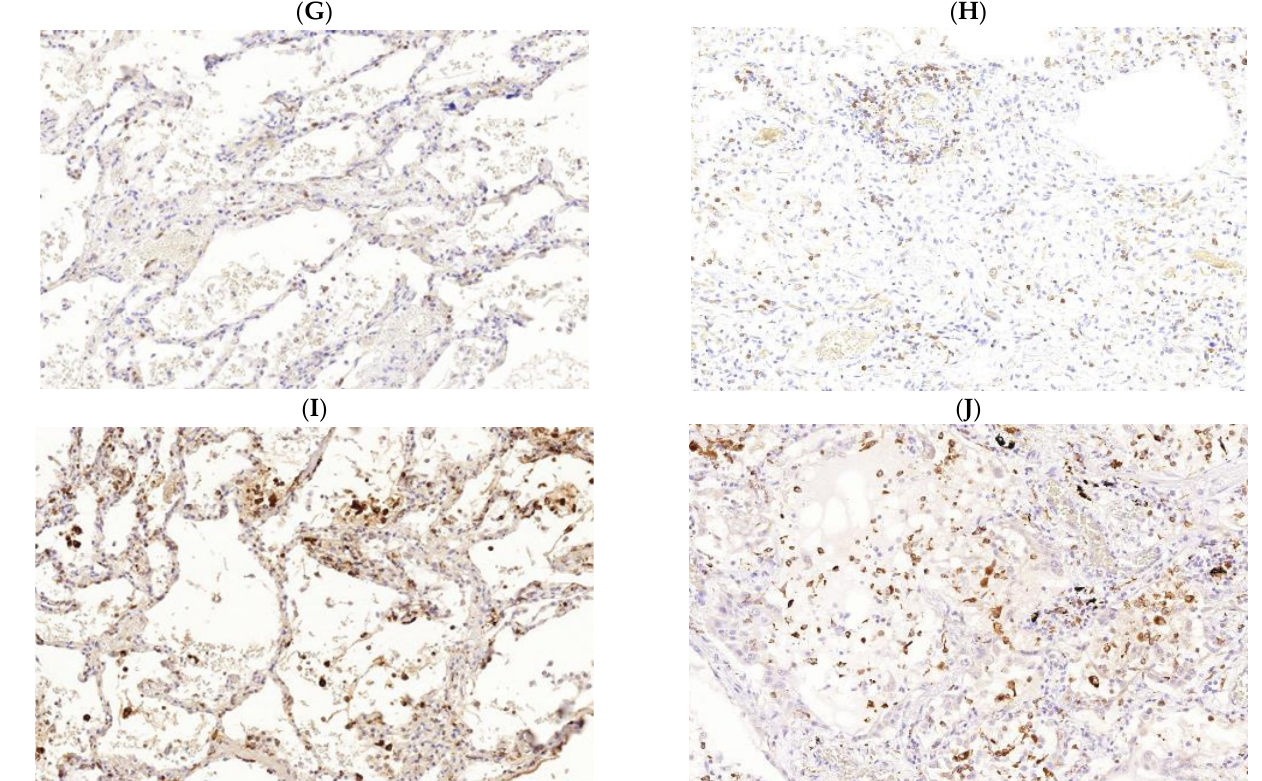
Figure 2. Immunomorphological characteristics of pathological cellular infiltration of the stroma of the lung’s respiratory parts among patients with new coronavirus infection caused by SARSCov2 (COVID-19). Acute (exudative) phase of diffuse alveolar damage (left). ( A ) staining with hematoxylin and eosin, ×400; ( C ) expression of CD3 (clone SP7, Diagnostic BioSystems, Pleasanton, CA, USA), ×400; ( E ) expression of CD4 (clone SP35, Cell Marque, Rocklin, CA, USA), ×400; ( G ) expression of CD8 (clone 144B, Diagnostic BioSystems, USA), ×400; ( I ) expression of CD68 (clone Kp-1, Cell Marque, USA. Late (proliferative) phase of diffuse alveolar damage (right). ( B ) staining with hematoxylin and eosin, ×400; ( D ) expression of CD3 (clone SP7, Diagnostic BioSystems, USA), ×400; ( F ) CD4 expression (clone SP35, Cell Marque, USA), ×400; ( H ) CD8 expression (clone 144B, Diagnostic BioSystems, USA), ×400; ( J ) CD68 expression (clone Kp-1, Cell Marque, USA), ×400.